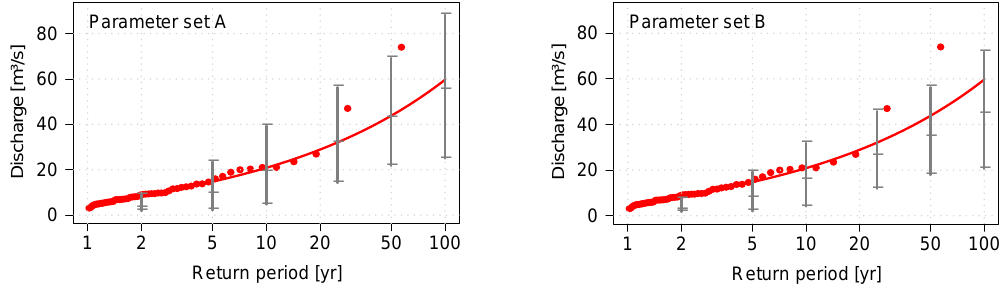
Figure 9 . Range and median of simulated design flows based on 15 model runs using KOSTRA rainfall data representing the 90%-confidence interval against observed peak flows for the Silberhütte catchment; left: parameter set A, right: parameter set B